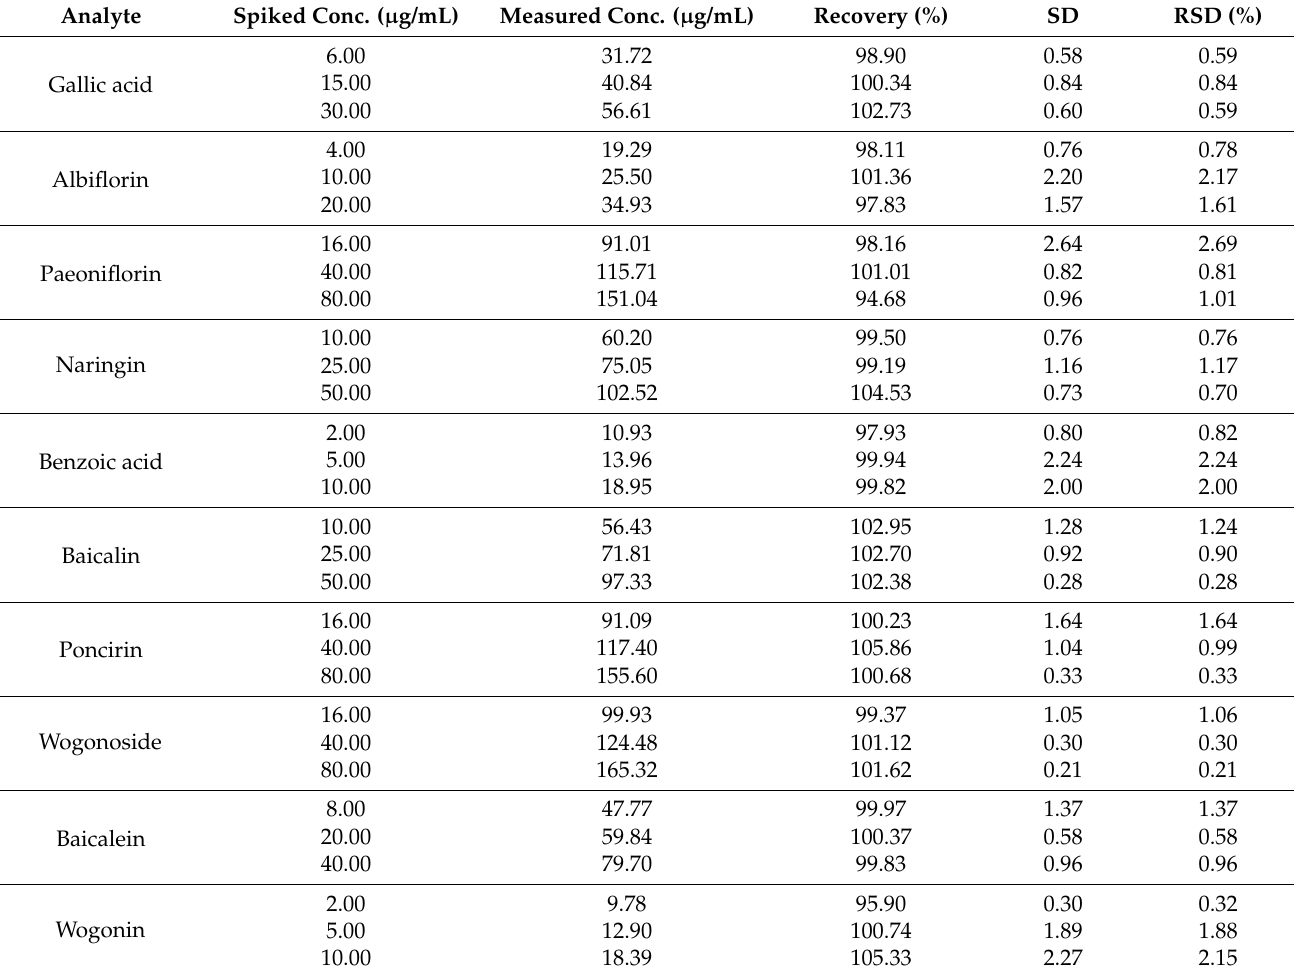
Table 2. Extraction recovery (%) of the 10 markers in the developed HPLC assay ( n = 5).